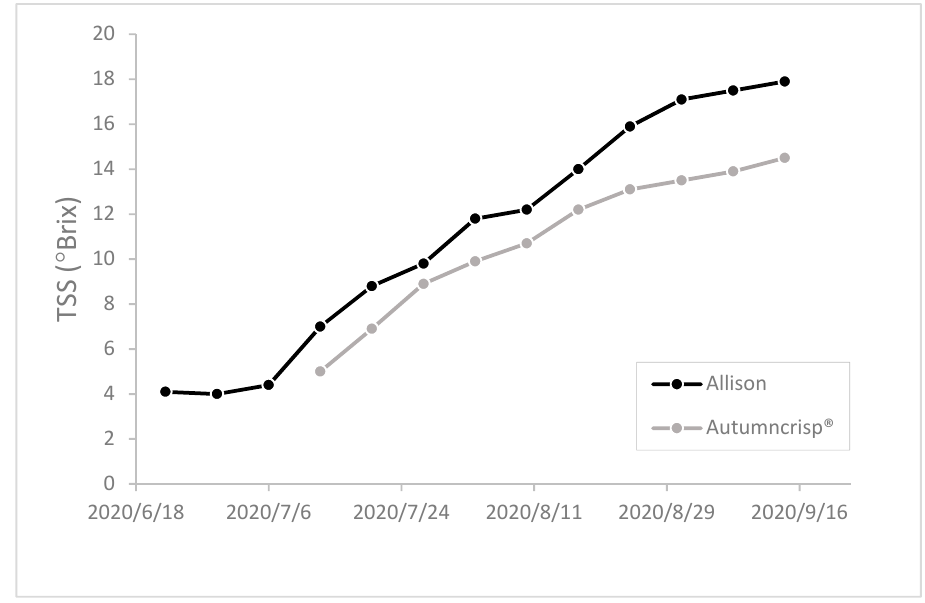
Figure 2. TSS (°Brix) evolution in Allison™ and Autumncrisp ® in the season 2020.